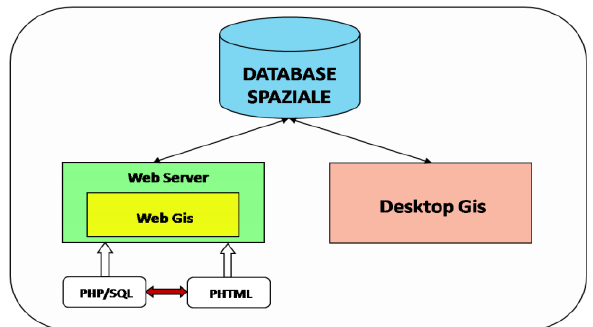
Figure 3. Architecture of the integrated GIS platform